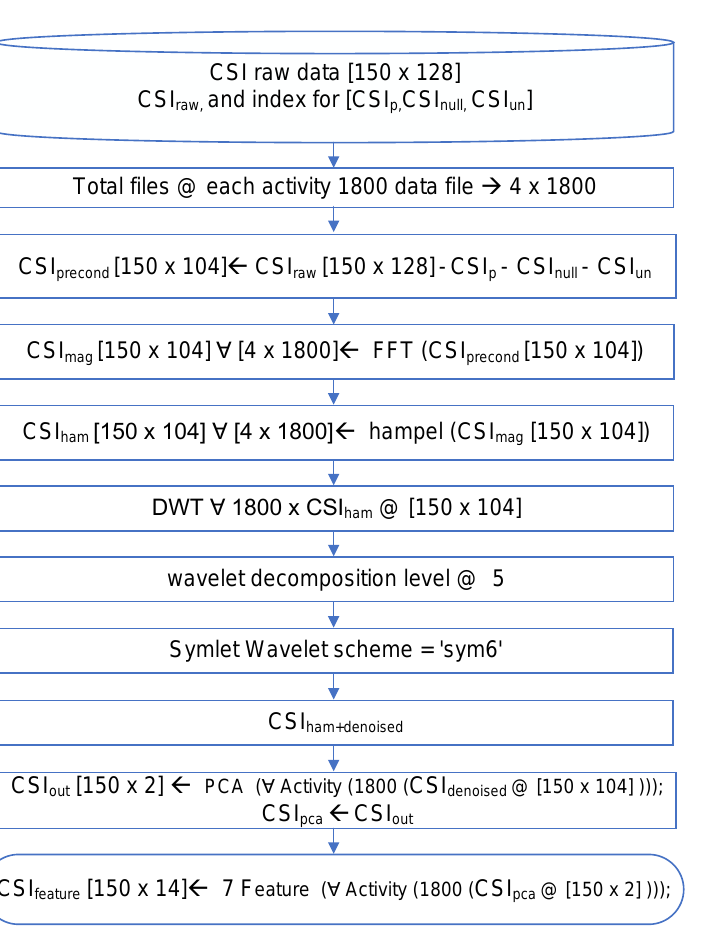
Figure 7. CSI-denoised using Hampel, DW00, and then